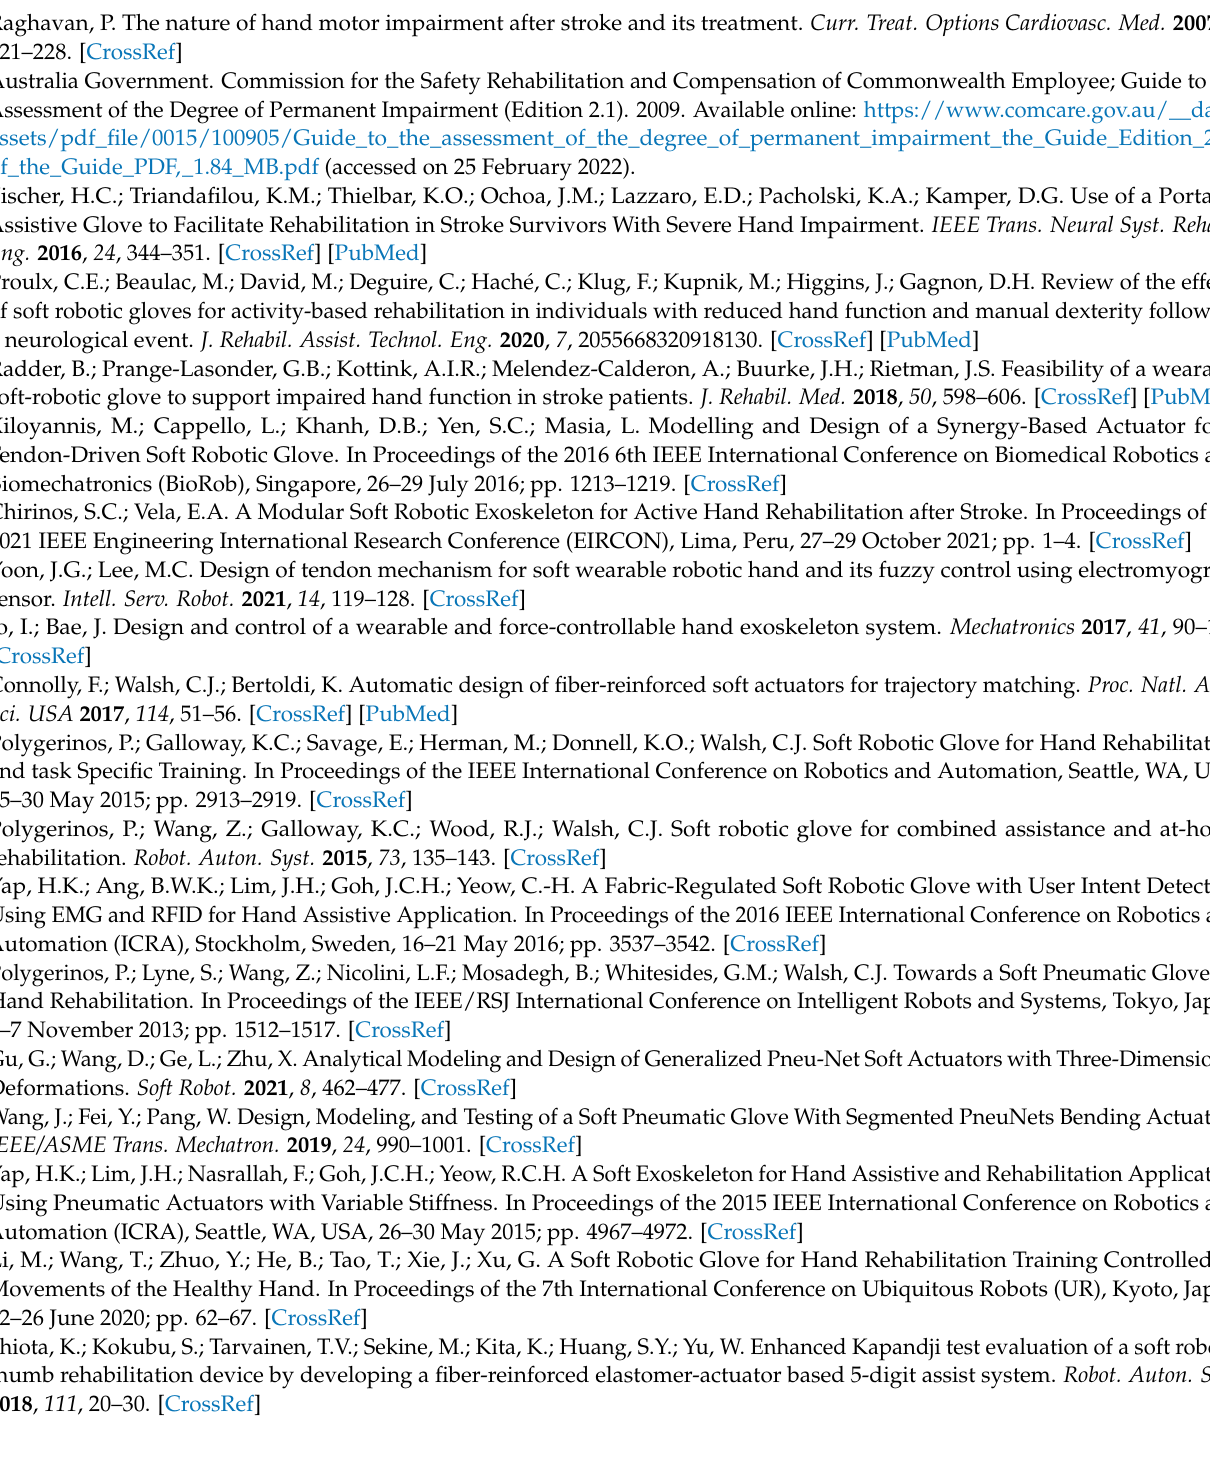
Strategy one (Figure A1A): abduct the thumb first, then flex the thumb joints. The 3C-ACT achieved thumb–small opposition in 18 s, whereas the M-ACT had to repeatedly adjust the air inflation in the two modules of the CMC unit (from 12 to 28 s) and did not achieve thumb–small opposition after a sequence of air pressure adjustments. Strategy two (Figure A1B): flex the thumb joints first, then abduct the thumb. Both the 3C-ACT and M-ACT realized thumb–ring opposition within 18 s. 3C-ACT: three-chamber actuator; M-ACT: modular type of thumb